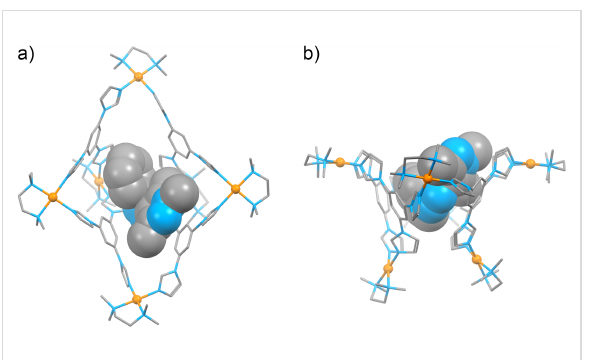
Figure 5: Top view (a) and side view (b) of the energy-optimized struc- ture of ( Z - 1 ) 2 . Color codes: C, gray; N, blue; Pd, orange. Hydrogens and counterions are not shown for clarity.